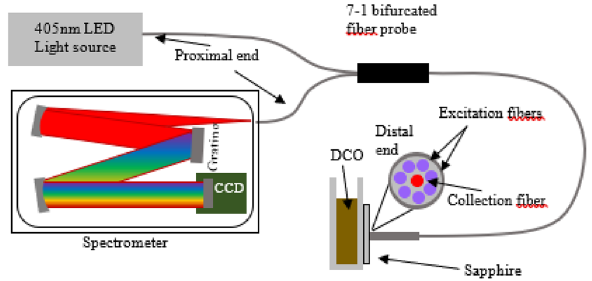
Figure 1. Schematic diagram of LICF setup used in the laboratory for the LIF